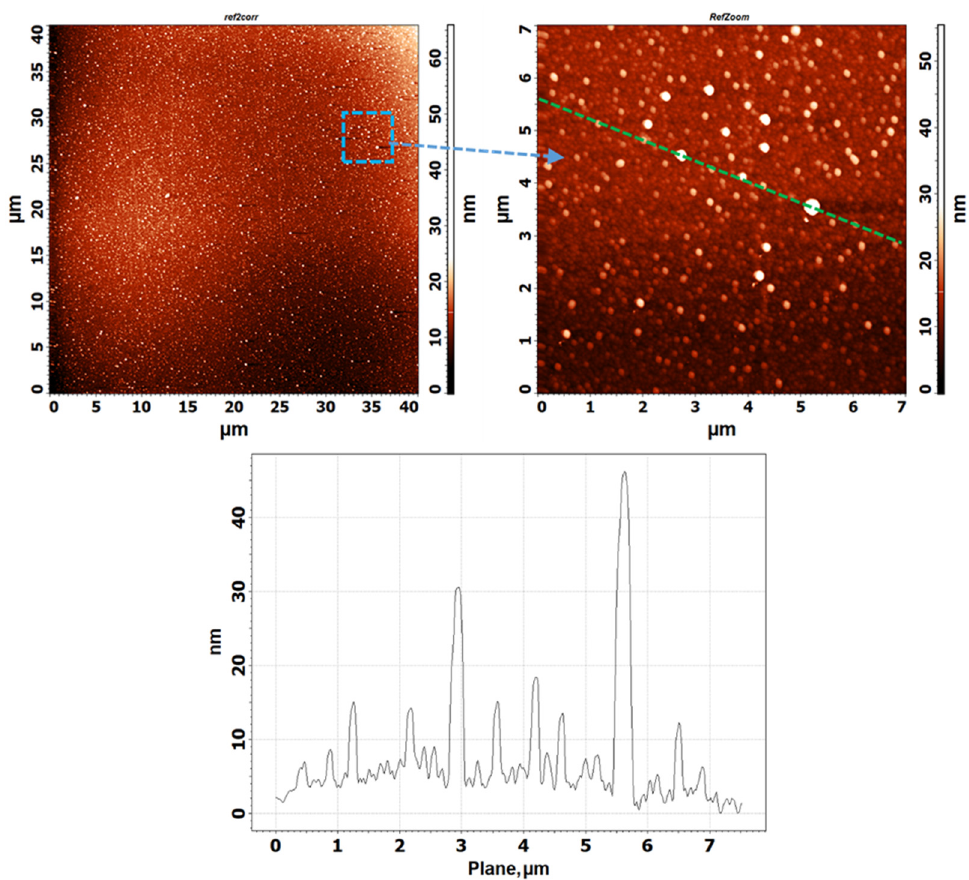
Figure 2. AFM images of the metal surface of surface-enhanced Raman scattering (SERS)-active substrates without protein samples applied. The left panel shows a 40 × 40 µ m area; the right panel shows the image obtained in the area marked with a blue square in the left panel (7 × 7 µ m); the bottom panel shows the cross-section along the green line in the right panel.